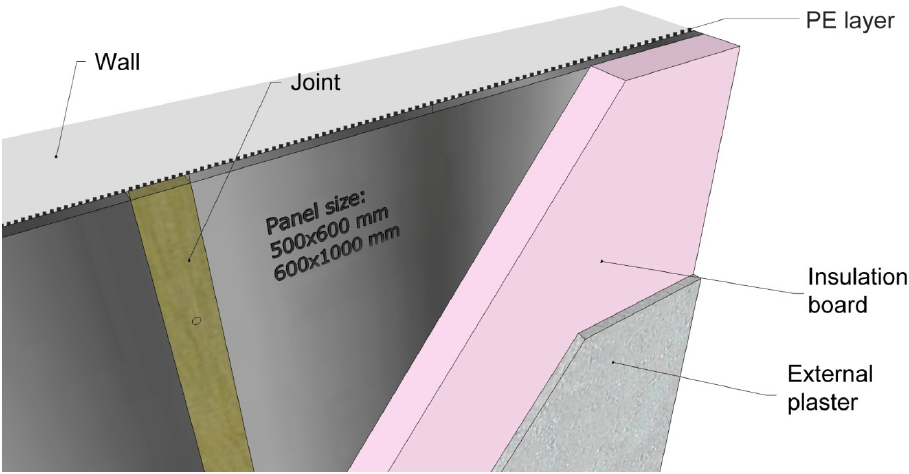
Figure 4. 3D scheme of a typical building insulation